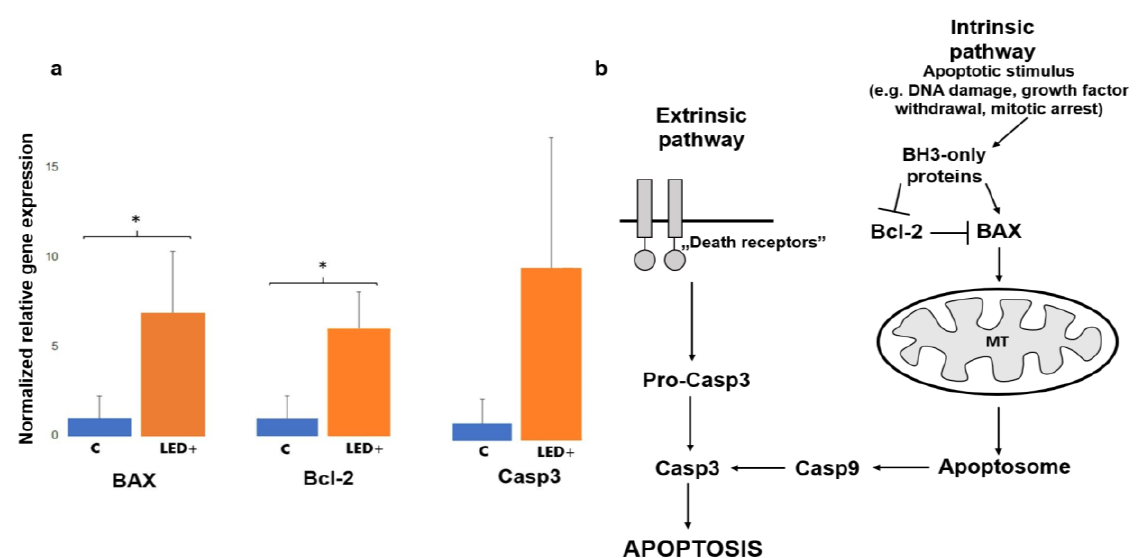
Figure 1. Bax, Bcl-2, and Casp3 gene expression in the retina of control and LED-treated mice. ( a ) Histograms show the relative mRNA expression of Bax, Bcl-2, and Casp3 as measured in control (normalized to 1) and LED-treated mice ( n = 8, 4 control, 4 LED +). (* p = 0.05; p Casp3 = 0.1). ( b ) The main players of apoptosis. Casp3 is the link between intrinsic and extrinsic pathways, while Bcl-2 has a role in survival.